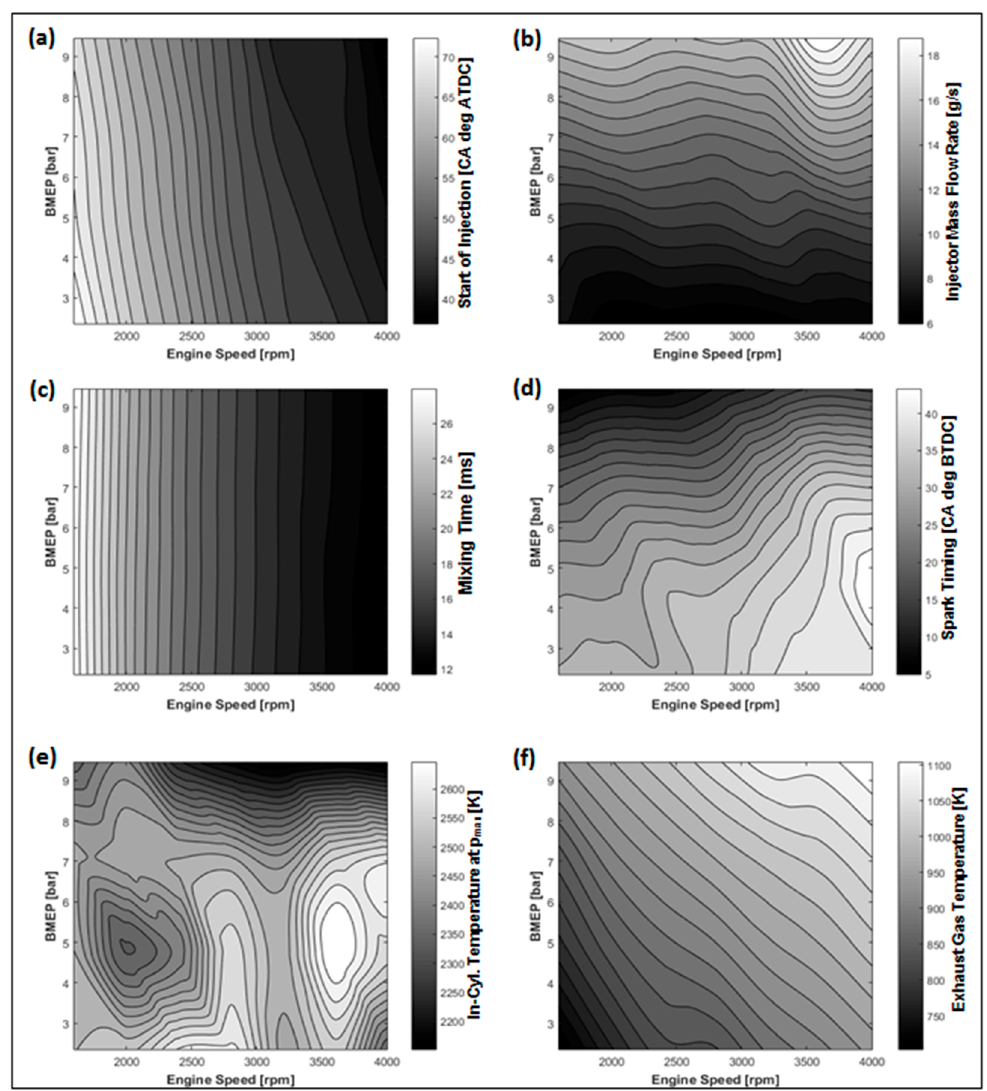
Figure 3. Engine control and combustion parameters as a function of engine speed (rpm) and BMEP (bar). ( a ) Start of injection; ( b ) injector fuel mass flow rate; ( c ) mixing time (time interval between EOI and ST); ( d ) spark ignition timing; ( e ) in-cylinder gas temperature at maximum pressure; and ( f ) exhaust gas temperature.